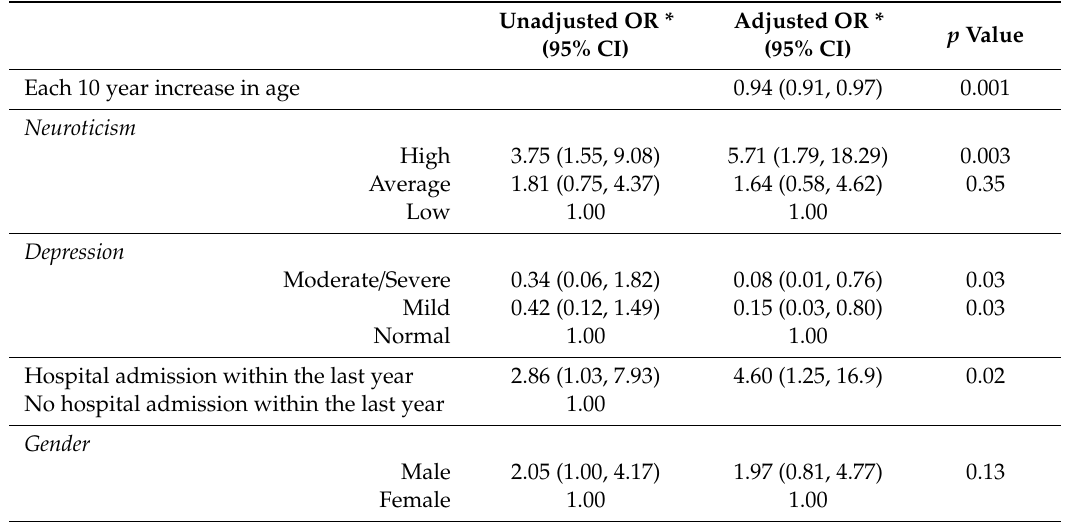
Table 6. Predictors of non-adherence to inhaled corticosteroid therapy identified in a multi-variate model. Unadjusted OR * Adjusted OR * p Value (95% CI) (95% CI) Each 10 year increase in age 0.94 (0.91, 0.97) 0.001 Neuroticism High 3.75 (1.55, 9.08) 5.71 (1.79, 18.29) 0.003 Average 1.81 (0.75, 4.37) 1.64 (0.58, 4.62) 0.35 Low 1.00 1.00 Depression Moderate / Severe 0.34 (0.06,